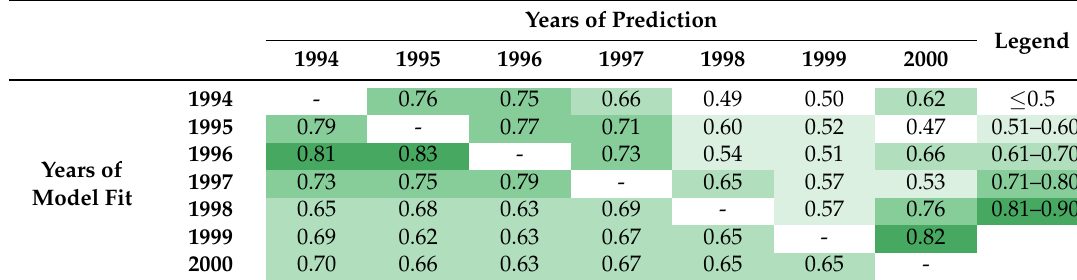
Table 4. Ability of fitted full models for each individual year (rows) to predict bark beetle forest infestation in the years 1994 to 2000 (columns), except the same year for which the model was fitted, evaluated using AUC. Higher AUC values mean higher predictive power of the respective models; value 0.5 represents random